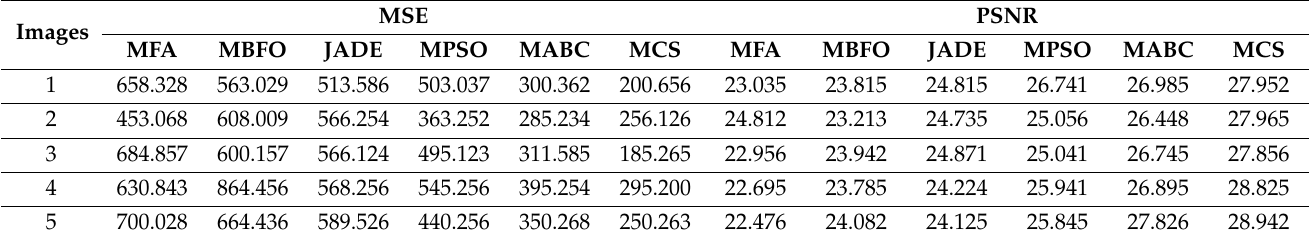
Table 10. MSE and PSNR using different optimization algorithms with R é nyi’s entropy.